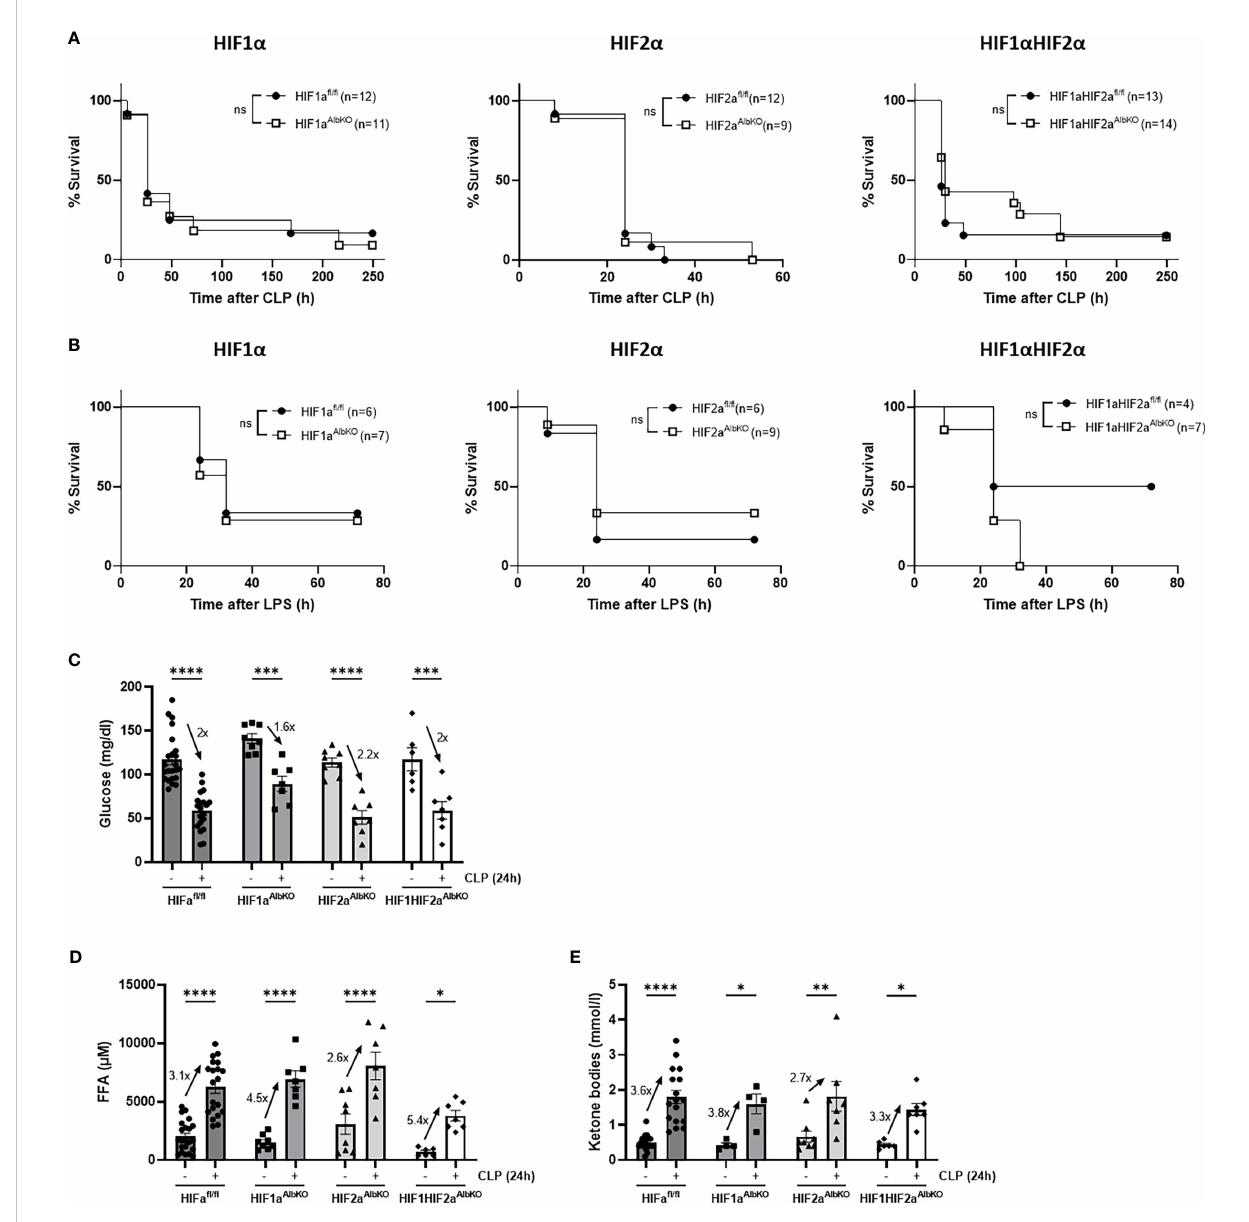
FIGURE 5 Lack of survival bene fi t in CLP-induced polymicrobial sepsis or LPS-induced endotoxemia in the absence of HIF1 a and/or HIF2 a in hepatocytes. HIF1a AlbKO , HIF2a AlbKO , and HIF1aHIF2a AlbKO mice and wild-type littermates were subjected to CLP (A) or injected with 11.25 mg/kg LPS (B) . Survival was monitored over time. N-values are indicated in the fi gure. Survival curves were analyzed with Log-Rank test. (C-E) HIF1a AlbKO , HIF2a AlbKO , and HIF1aHIF2a AlbKO mice and wild-type littermates were subjected to a sham or CLP procedure. After 24h, glucose (C) and ketone bodies (E) were measured via the tail vein. FFA levels (D) were determined in the plasma of these mice. Fold inductions are shown on the fi gures. All bars represent mean ± SEM. P-values were analyzed with two-way ANOVA. ****P < 0.0001, ***P < 0.001, **P < 0.01, *P ≤ 0.05. ns, non-signi fi